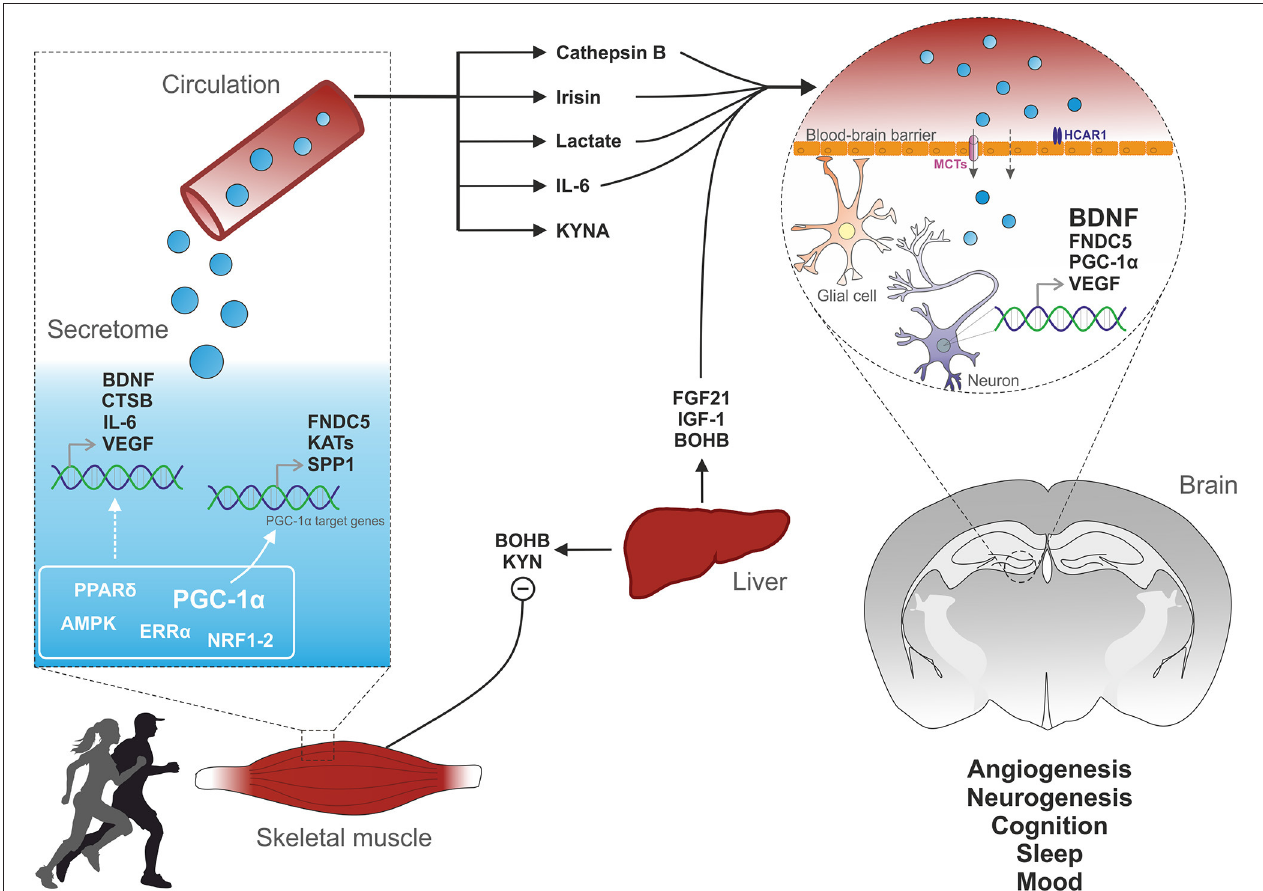
FIGURE 1 | Muscle-brain crosstalk. Physical exercise activates specific cellular pathways in muscle cells. For instance, PGC-1 α activation induces the expression of FNDC5, which is cleaved to irisin and released into the circulation. PGC-1 α elevation also leads to the biosynthesis of kynurenine aminotransferases (KATs) which converts liver-derived KYN to KYNA, thus preventing its toxic accumulation into the brain. The endocrine property of muscle cells is further illustrated by the release of cytokines (e.g., IL-6) or metabolites (e.g., lactate). Physical activity also promotes the production and release into the blood of various factors from non-muscle tissues such as the liver. Subsequently, muscle- and liver-derived molecules enter the brain and signal on receptors located on endothelial, glial or neuronal cells, thereby triggering the expression of VEGF and BDNF, key regulators of cerebral vascularization and plasticity.